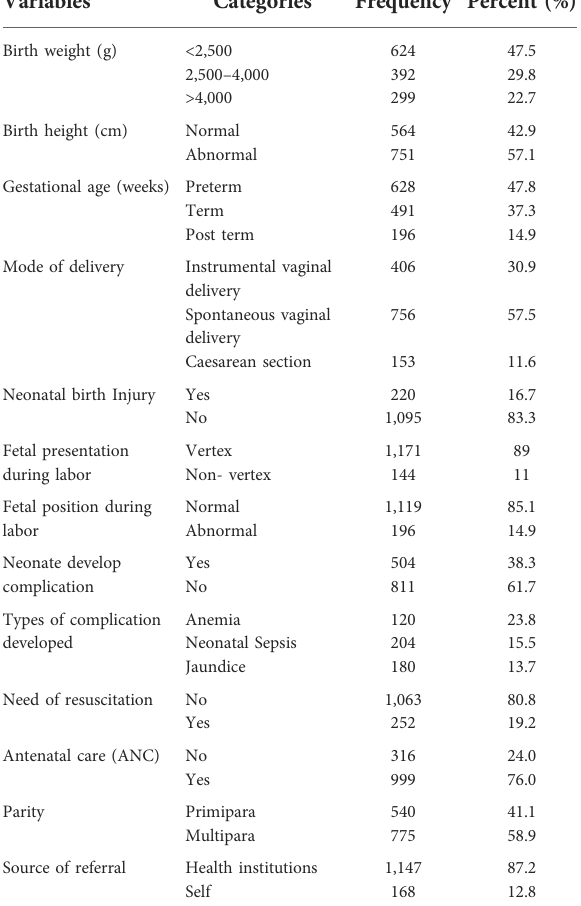
TABLE 2 Obstetrical and neonatal characteristics women who gave birth at governmental hospitals of Southwest Ethiopian people regional state, Ethiopia,